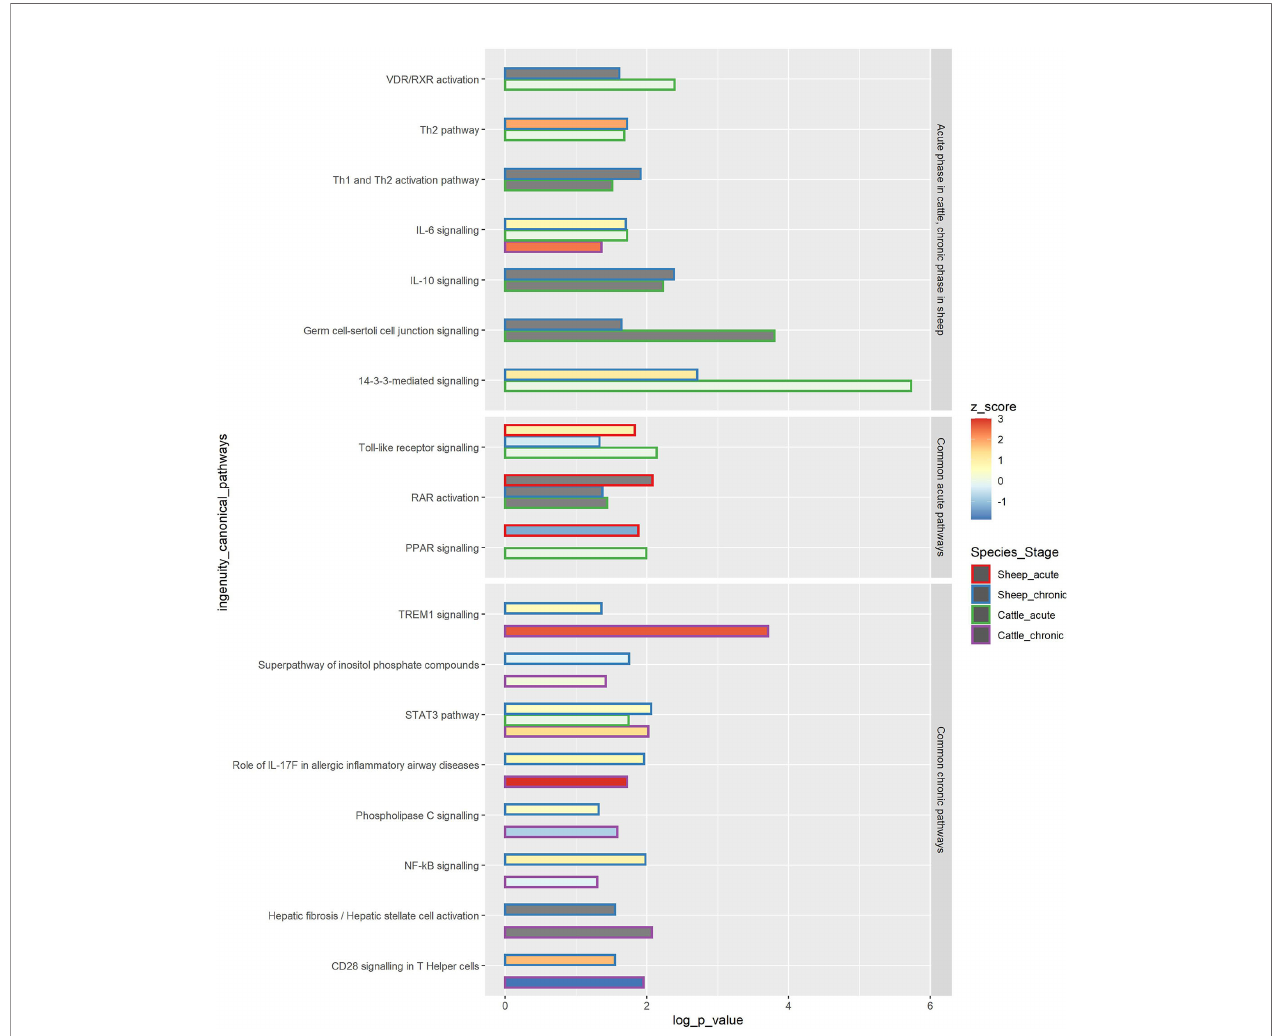
FIGURE 7 | Common IPA canonical pathways in PBMC at the acute and chronic stages of F. hepatica infection in sheep and cattle. The common pathways are subdivided into 3 squares: pathways occurring in the acute phase in cattle and in the chronic phase in sheep, common acute pathways and common chronic pathways. The length of the bar represents -log P value, colour within the bar represents the z score, with the z score of 0 being represented by a light green colour, and z score not determined represented by grey bar colour. The outline of the bar represents the species (sheep or cattle) and disease stage (acute or chronic). – log ( P value) - The probability of association of genes from our data set with the canonical pathway by random chance alone using Fisher ’ s exact test. z-score - Overall activity status of the pathway. Z < 0 indicates a prediction of an overall decrease in activity while Z > 0 predicts an overall increase in the activity. Grey colour of the bar indicates pathways that are currently ineligible for a